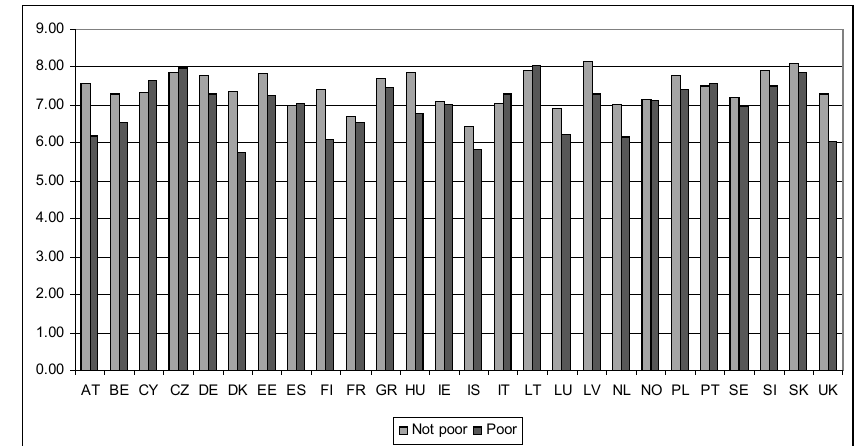
Figure 4 : Average age child by